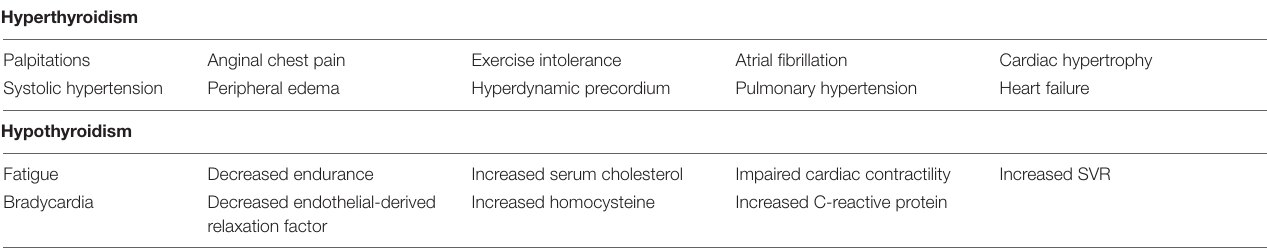
TABLE 1 | Cardiovascular clinical manifestations and laboratory findings associated with hyperthyroidism and hypothyroidism (Danzi and Klein, 2014).